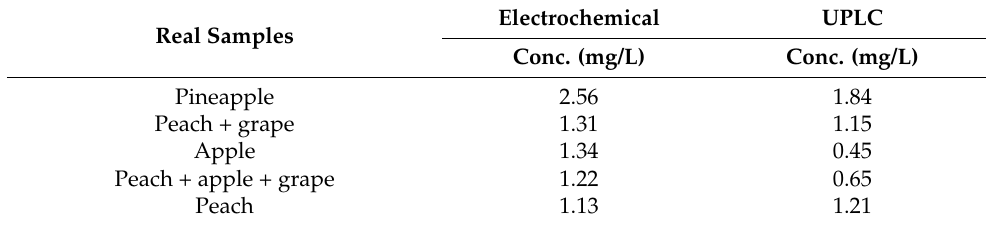
Table 7. Concentration of tryptophan in some analyzed fruit